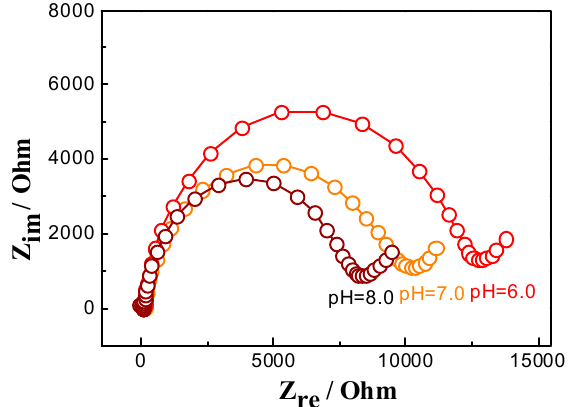
Figure 5. Nyquist plot (Zim vs. Zre) for Faradaic impedance measurements in the presence of 5.0 mM K 3 [Fe(CN) 6 ]/K 4 [Fe(CN) 6 ] and 0.1 M KCl with different pH values. A GCE modified by PS– b –PAA